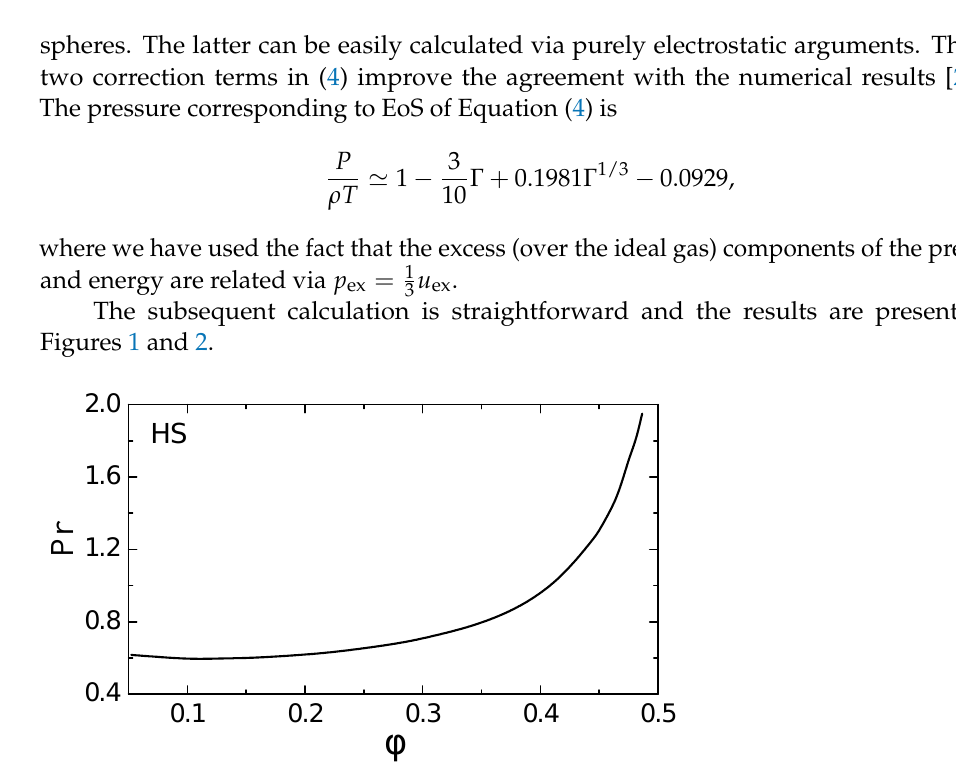
Figure 1. Prandtl number, Pr, of a hard-sphere (HS) fluid versus the packing fraction φ .